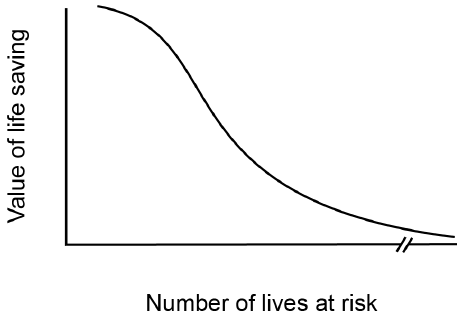
Figure 4. A model depicting psychic numbing–compassion fade–when valuing the saving of